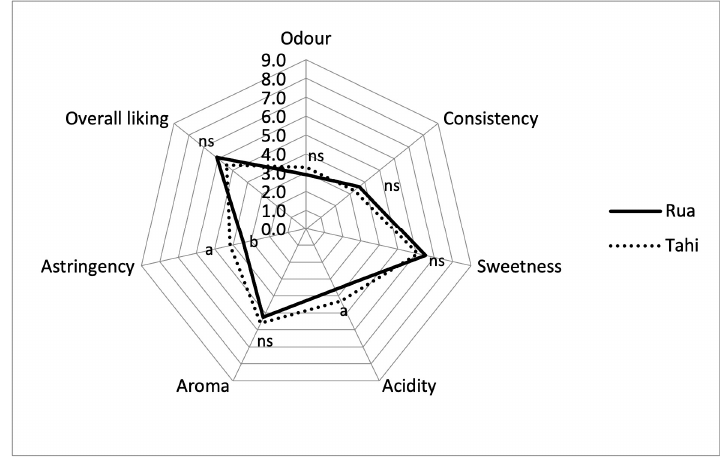
Figure 3. Sensory profiles of Actinidia arguta cv. Rua and cv. Tahi.